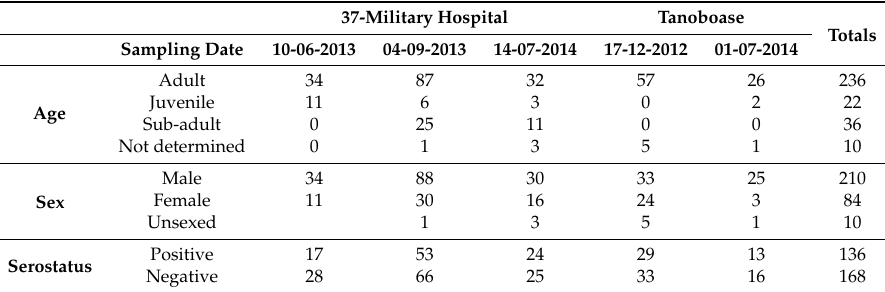
Table 1. Sample data